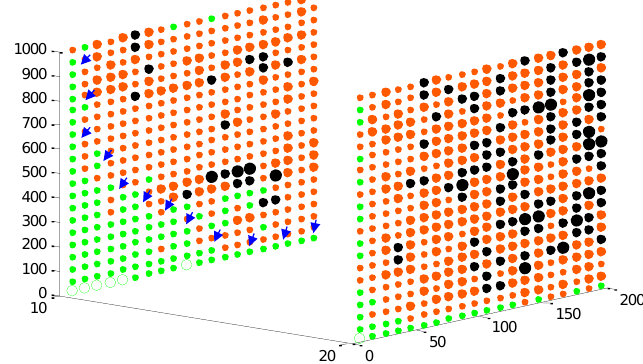
Fig. 11. The almost key “angle bar” from Fig. 5, which supports inference